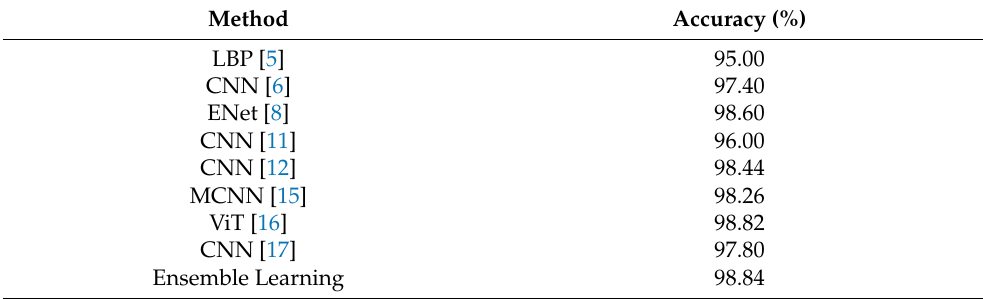
Table 12. Comparative results on GTSRB dataset.